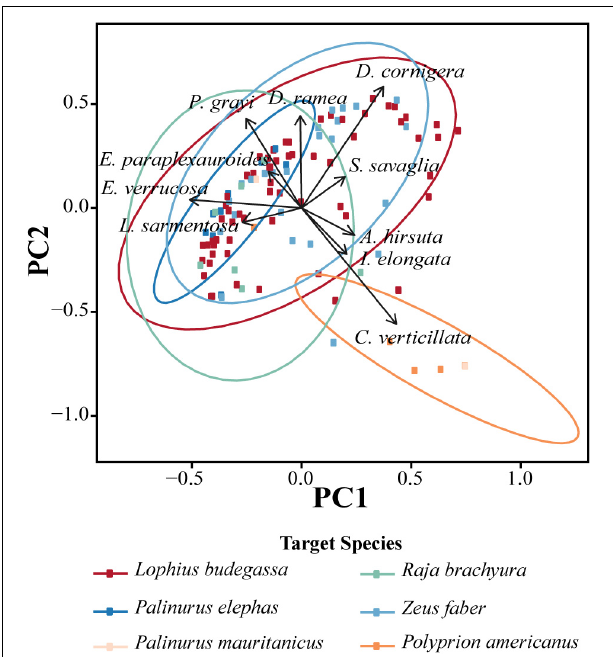
FIGURE 8 | Variation of the coral community according to the depth (db-RDA), from the assessment of coral bycatch using bottom-set gillnets during two sampling seasons off the coast of Sagres (Portugal). Species composition per net was converted to a resemblance matrix using Hellinger distance and the variable depth described as constrained ordination axis. The vectors display the Pearson correlations ( p -value < 0.05) between the descriptors (i.e., coral species captures per net) and the dbRDA1 and PCoA1. Db-RDA biplot shows the variation of the coral community according to the depth at which nets were deployed. The depth vector indicates the trend from shallow (left) to deep (right). Significant groupings defined by métier are shown in color. For more information concerning the db-RDA refer to Section “Materials and